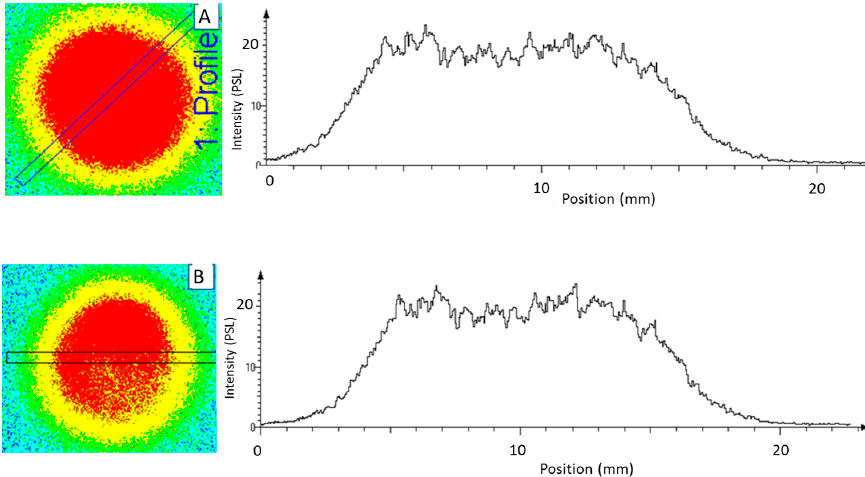
Figure 2. Autoradiographs (left) and profile of radioactivity distributions (right) of the 241 Am alpha sources: ( A ) diamond and ( B ) stainless steel substrates. Electro-precipitation conditions: 0.3 M Na 2 SO 4